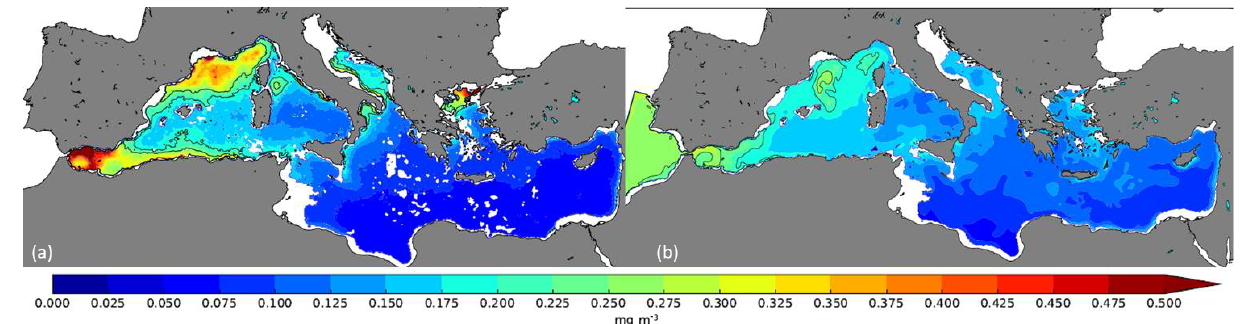
Figure 1. Satellite map of average surface chlorophyll a concentration from Bosc et al. (2004) (1997–2004, a ) and modeled average surface chlorophyll a concentration (b) . Model and satellite data are filtered for coastal waters (white areas). Additional white areas on the satellite maps represent a lack of data. Table 1. Average chlorophyll a concentration (spatial SD in brackets) and statistical indicators (spatial RMSE, normalized and relative bias) for different Mediterranean sub-basins (see Fig. 5 for the sub-basin limits). Values are calculated from Fig. 1. Coastal areas are filtered out as in Fig. 1. Basin Model mean ( σ ) Data mean ( σ ) RMSE Normalized bias % bias Whole Med. 0.137 (0.04) 0.140 (0.1) 0.06 − 0.01 − 0.4 West 0.175 (0.03) 0.215 (0.1) 0.08 − 0.10 − 23 Adriatic 0.155 (0.007) 0.205 (0.04) 0.06 − 0.13 − 31 Aegean 0.141 (0.02) 0.145 (0.1) 0.10 − 0.01 − 3 Ionian 0.108 (0.03) 0.094 (0.04) 0.03 0.07 13 Levantine 0.108 (0.2) 0.07 (0.02) 0.04 0.23